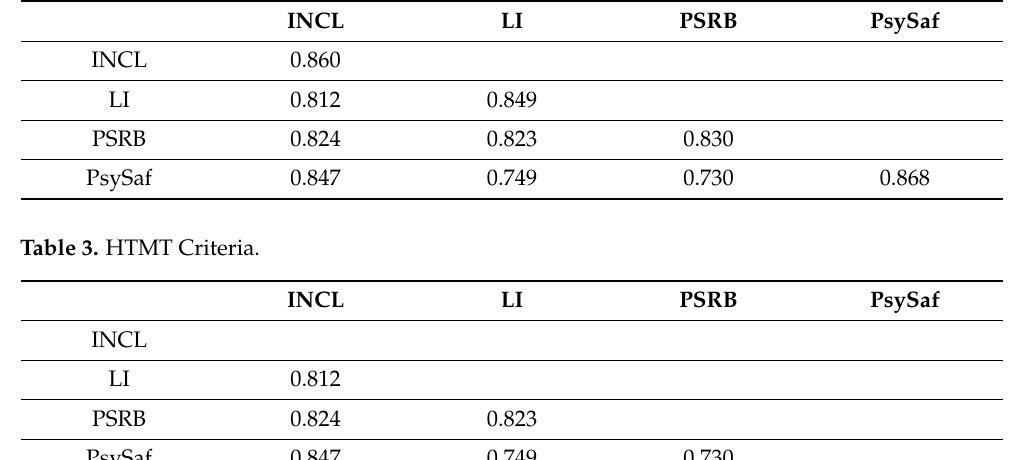
Table 2. Fornell-Larcker Criteria.